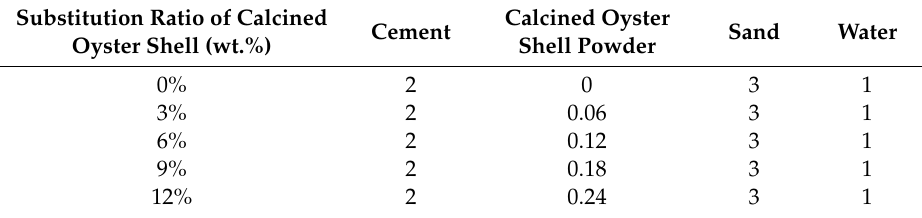
Table 2. Mixture proportion of mortar specimens used in this study expressed as mass